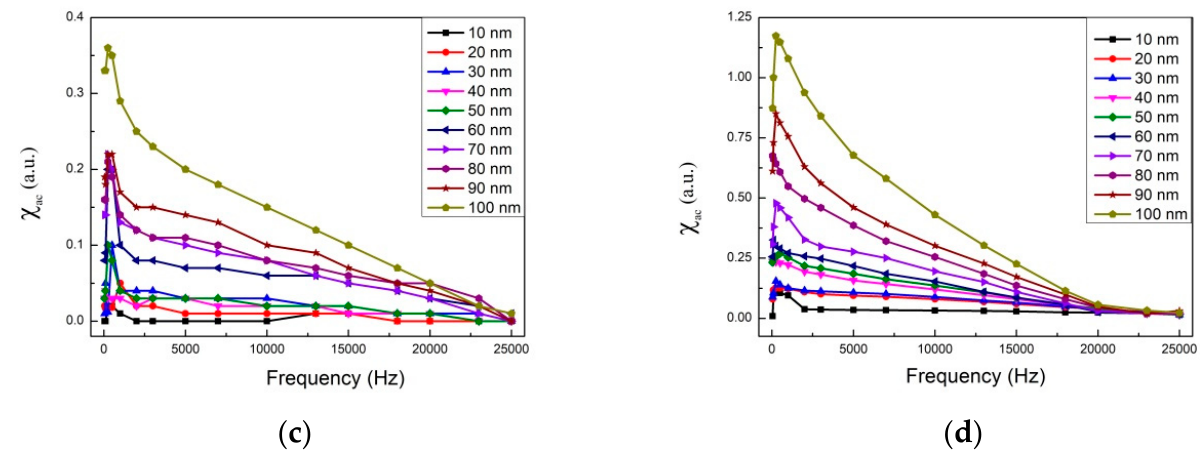
Figure 5. The low-frequency alternate-current magnetic susceptibility ( χ ac ) as a function of the frequency from 10 to 25,000 Hz: (a) after annealing at 200 °C, (b) after annealing at 250 °C, (c) after annealing at 300 °C, and (d) after annealing at 350 °C.